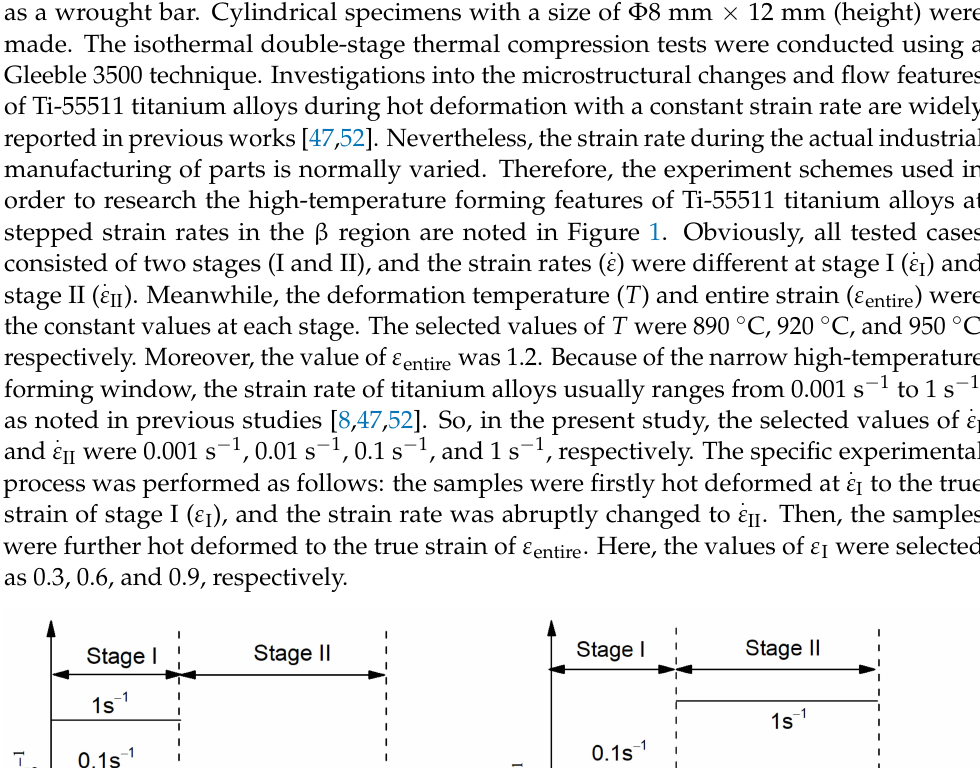
. . ε I into the constant ε II , ( b ) type II: the strain rates changed from the constant . ε II